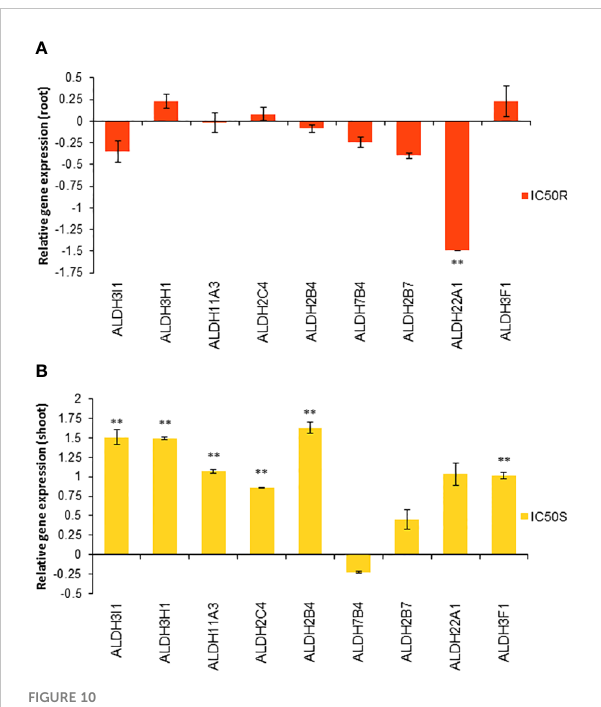
FIGURE 10 Relative gene expression of different ALDH genes in Arabidopsis seedlings treated with the IC 50 TC in roots (A) and shoots (B) for 14 d. Asterisks indicate signi fi cant differences compared to the root control for treated roots and to the shoot controls for treated shoots: ** ( p ≤ 0.05). Bars indicate standard